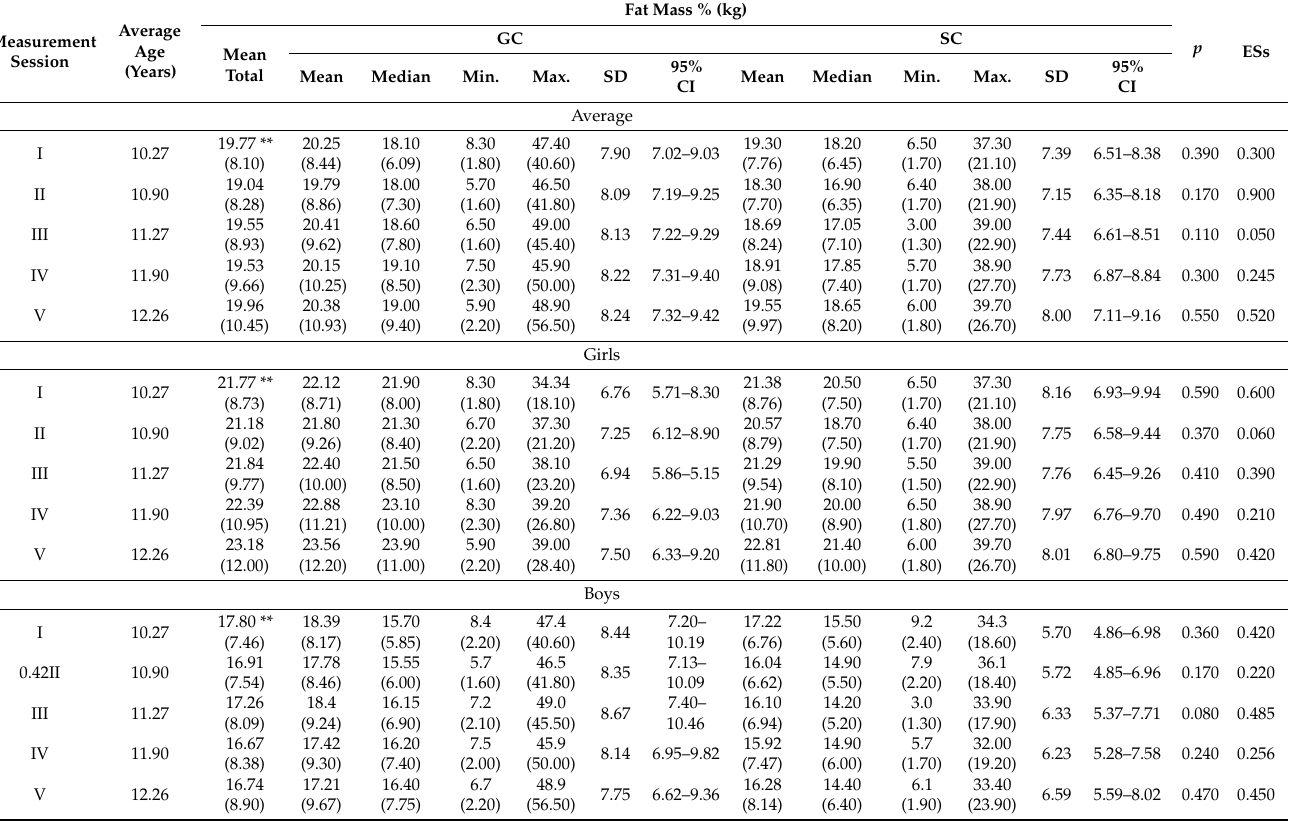
Table 1. Body fat content in GC and SC children, percentage (%), and weight units